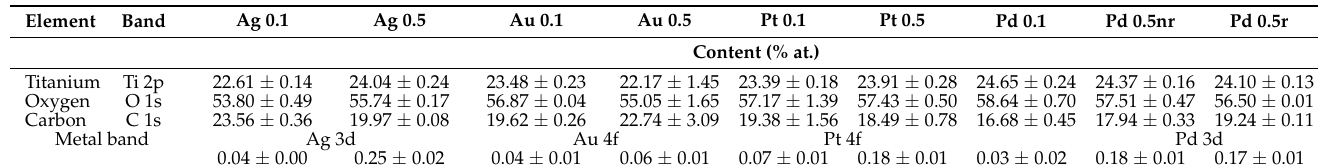
Table 1. Surface composition of studied photocatalytic films.